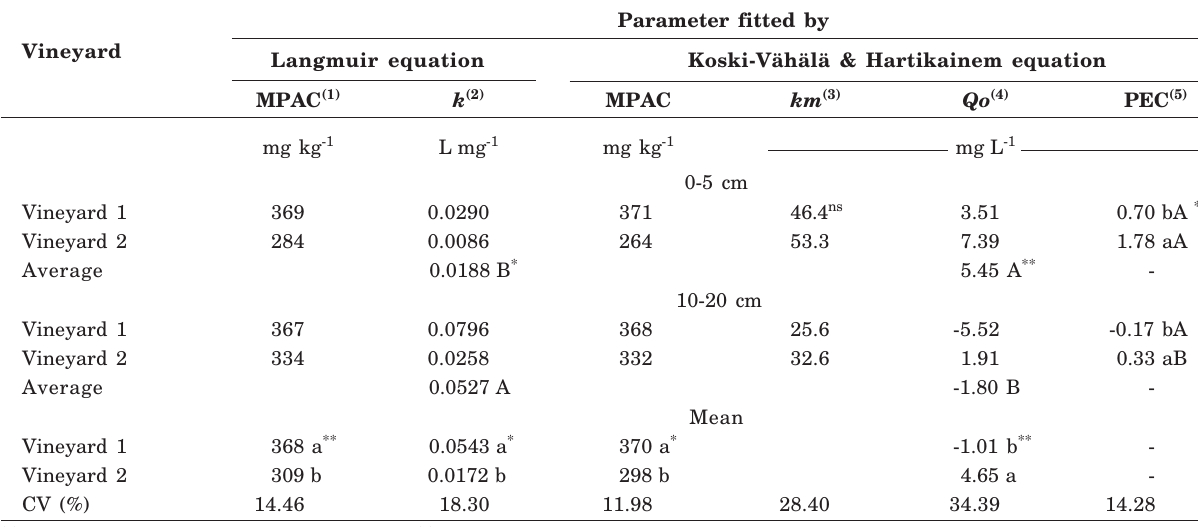
Table 4. Parameters related to phosphorus adsorption isotherms in the 0-5 and 10-20 cm layers in a Sandy Typic Hapludalf soil in